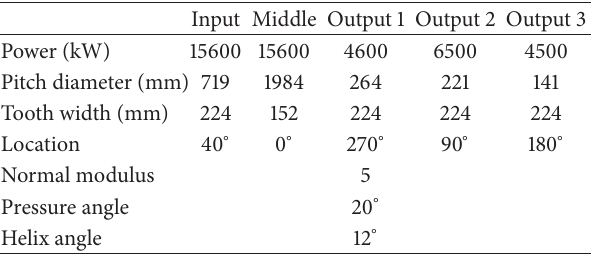
Figure 5: Dynamic model of the turbo-chiller rotor-bearing system in [9].